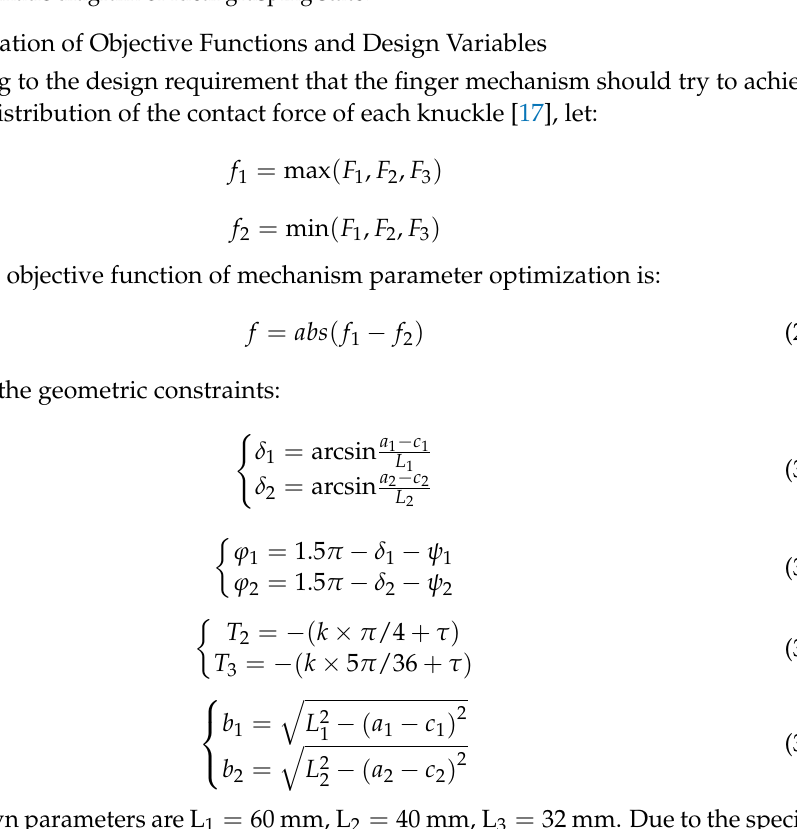
Figure 11. Schematic diagram of ideal grasping state .